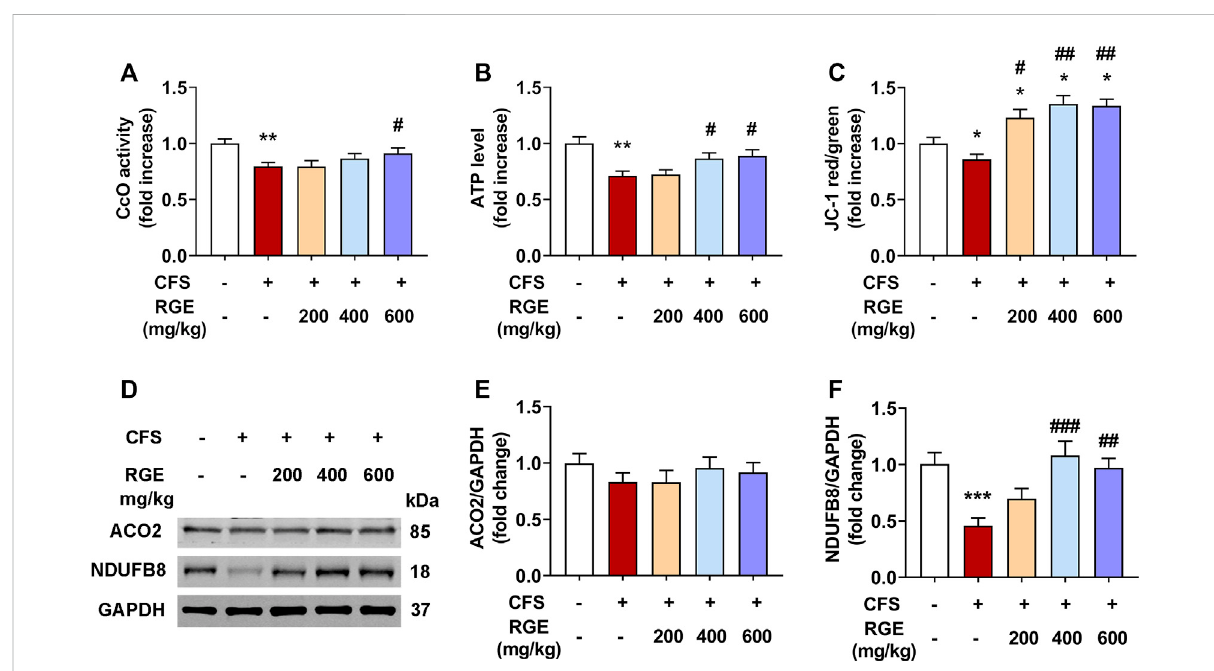
FIGURE 6 The effects of RGE on mitochondrial function-related indexes in chronic fatigue syndrome mice. (A – C) . Cytochrome c oxidase (CcO) activity (A) , ATP level (B) and mitochondrial membrane potential (JC-1 red/green, (C) in TA muscles of the indicated groups. (D) . Representative western blotting images of ACO2, respiratory chain complex I (NDUFB8) and GAPDH. (E,F) . Relative expression of ACO2 and complex I (NDUFB8) were quanti fi ed. n = 3 independent blots. Mice from control or chronic fatigue syndrome model group were treated with water or different dose of RGE (200, 400 or 600 mg/kg). n = 6 per group. Compared with control group, * p < 0.05, ** p < 0.01, *** p < 0.001; compared with CFS group, # p < 0.05, ## p < 0.01, ### p <